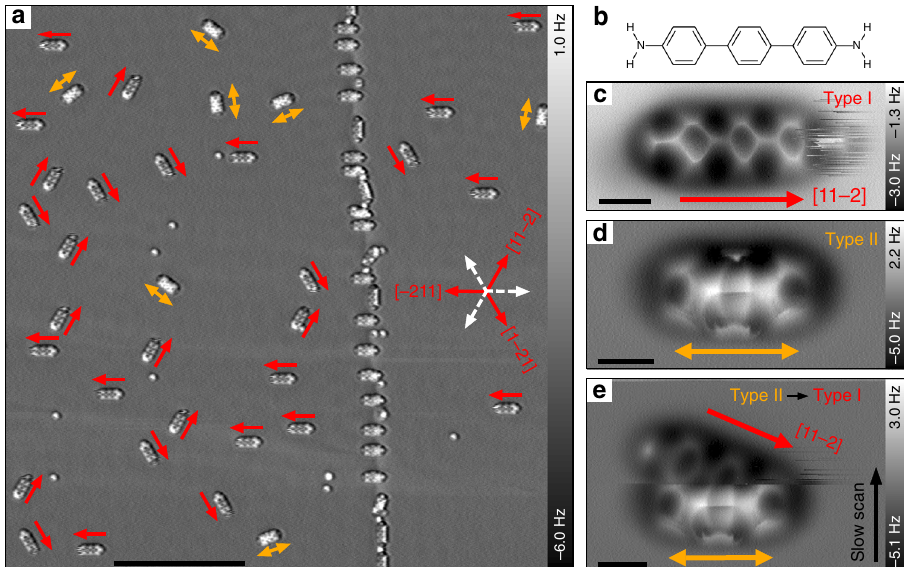
Fig. 1 Different adsorption geometries of DATP on Cu(111). a AFM frequency shift image showing two terraces (upper terrace in right and lower in left part) separated by monoatomic step. The tunneling current was used for tip-sample feedback. Imaging parameters: gap voltage = 10 mV, tunneling set point = 100 pA. Type I and II adsorption structures are indicated by red and orange arrows. Red arrows are pointing towards the fuzzy side of the type I structures. Symmetry reduction from six-fold to three-fold is observed, i.e., orientations that correspond to the three dashed white arrows are not observed on neither terrace. b Chemical structure of DATP. c , d Constant height AFM zoom-in images of type I and type II adsorption structures. e Transition from type II to type I during constant height upward scan. Parameters: the tip-heights Δ z are c + 20 pm, d − 85 pm, e − 85 pm, relative to a STM set point of 100 mV, 10 pA on bare Cu surfaces. The + / − signs represent increase/decrease of the tip-sample distance. Scale bars: a 10 nm, c – e 0.5